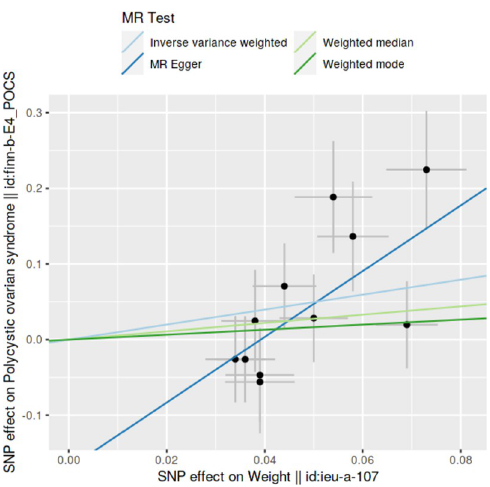
Fig 1. Scatter plot illustrating the distribution of individual ratio estimates of weight with polycystic ovarian syndrome as the outcome. Trend lines from the four different two-sample Mendelian randomization methods employed indicating the positive causal associations, are also included in each scatter